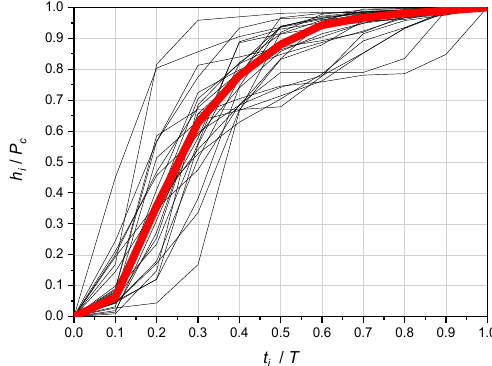
Figure 9. Dimensionless mass curves with a median for 15 convective (C) and 10 frontal (F with T ≤ 180 min) rainfall from clusters No. 3 and 4 (for k = 4).